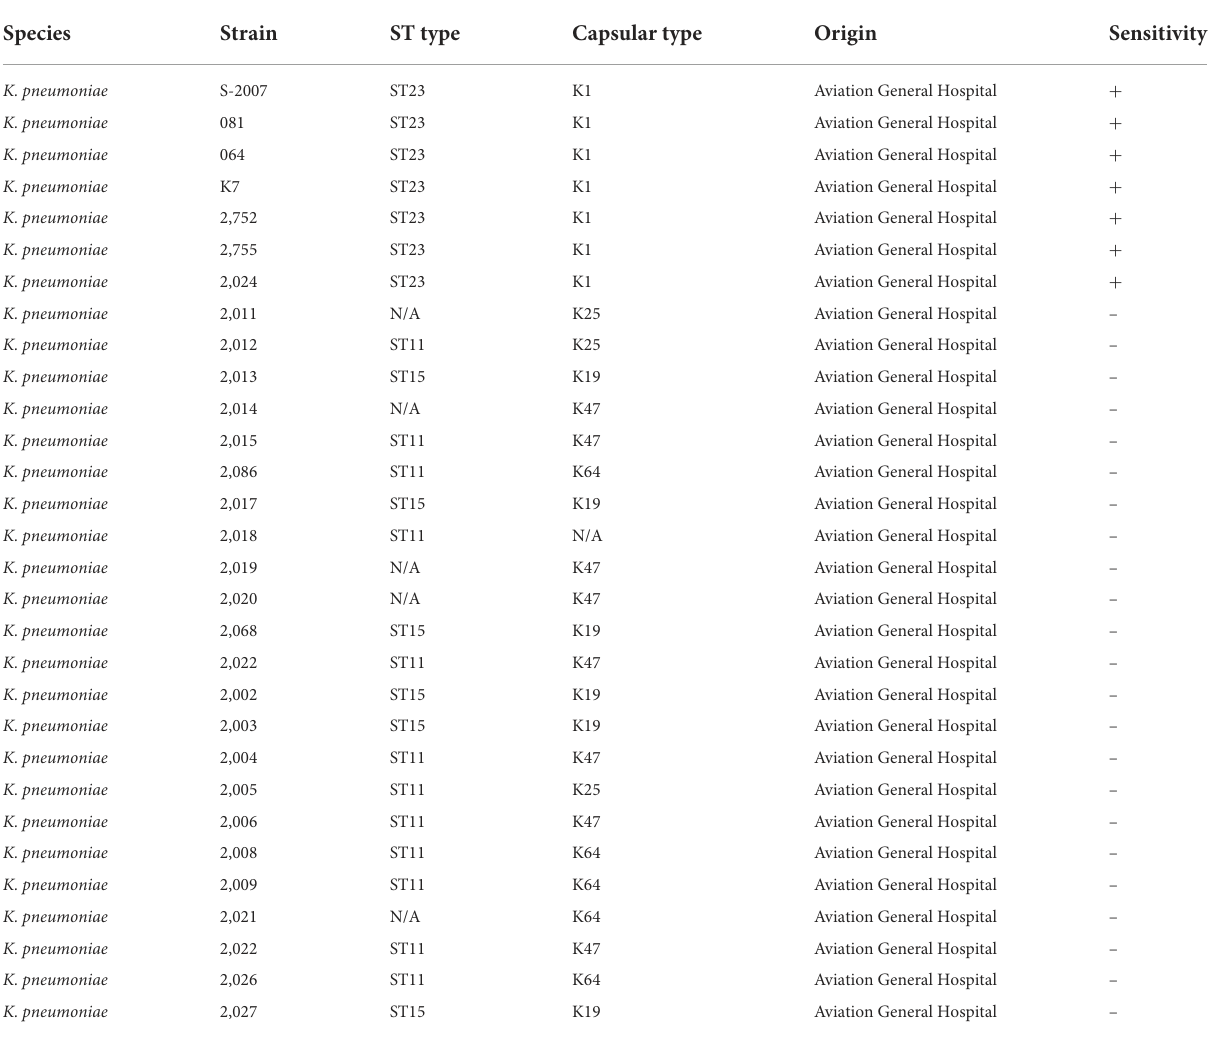
TABLE 1 Detail information of bacteria of host range tested.